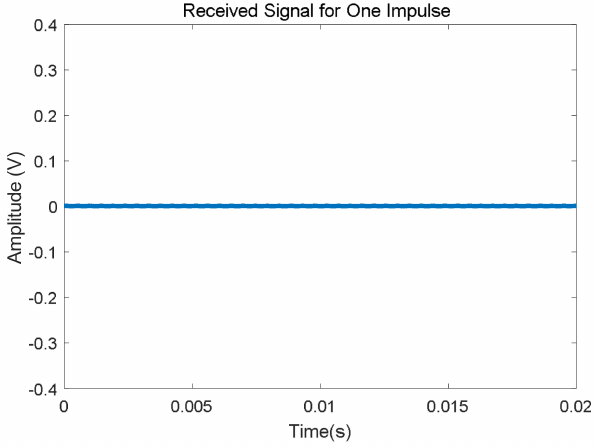
Figure 12. Zoom for a 20 ms window in the received UGW signal where pulse S 2 should be included, considering a breakage